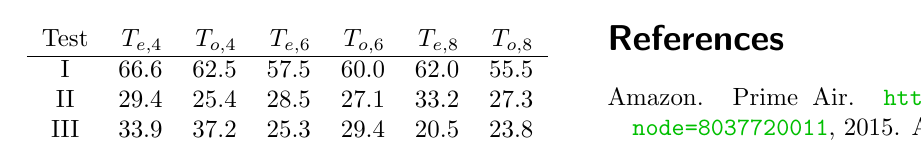
Table 14: Estimated flight times in minutes from the experiments T e,i vs. flight times calculated in the optimization T o,i for test cases I, II and III and 4, 6 and 8